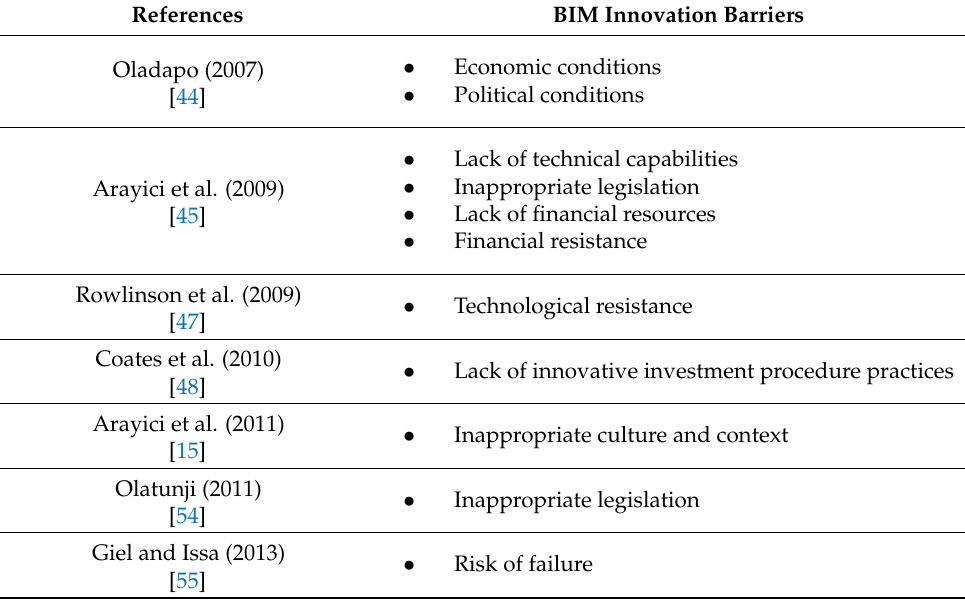
Table 3. The barriers to BIM